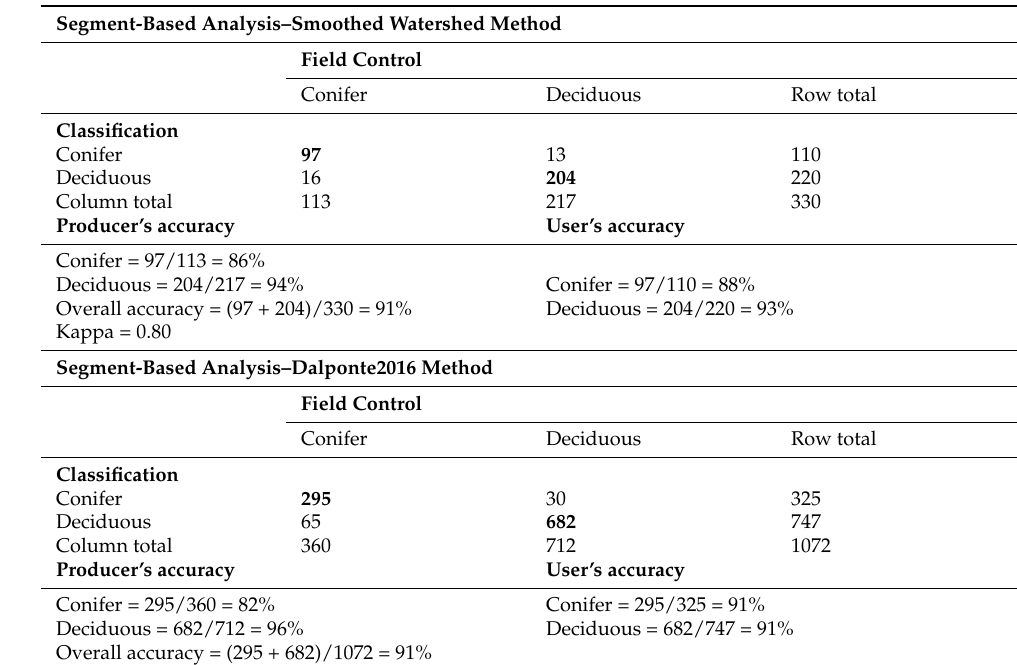
Table 7. Confusion matrix for individual tree-based composition models for dominant trees. For both segmentation methods, composition was modeled with a generalized linear mixed model [51] on mean intensity (scaled by 1/1000) with random intercepts and plot as a random